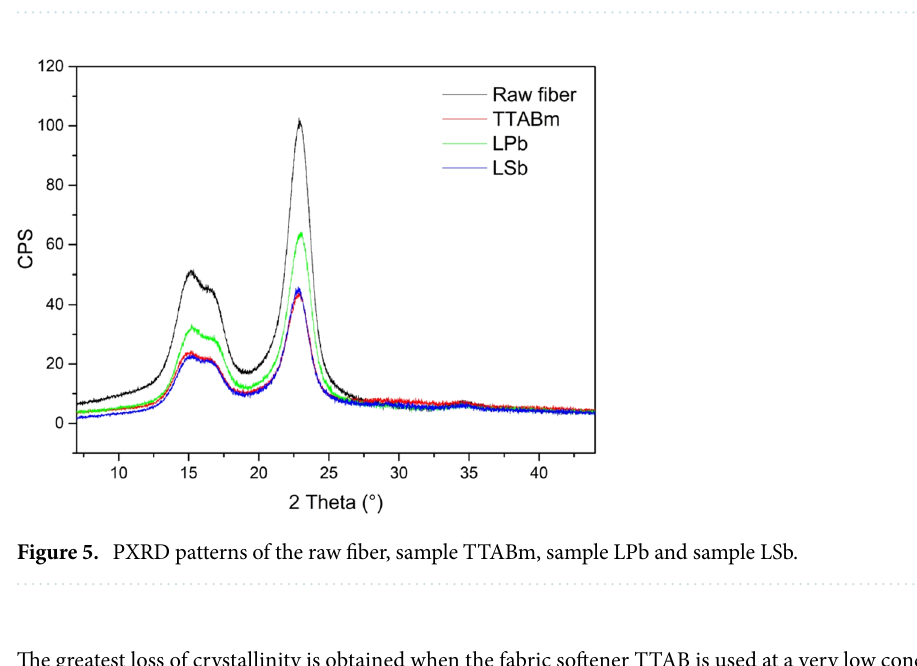
Figure 4. XRD profile of the raw fiber with its deconvolution curves (crystalline peaks: red lines; amorphous region: blue curve; cumulative fit curve: yellow line).